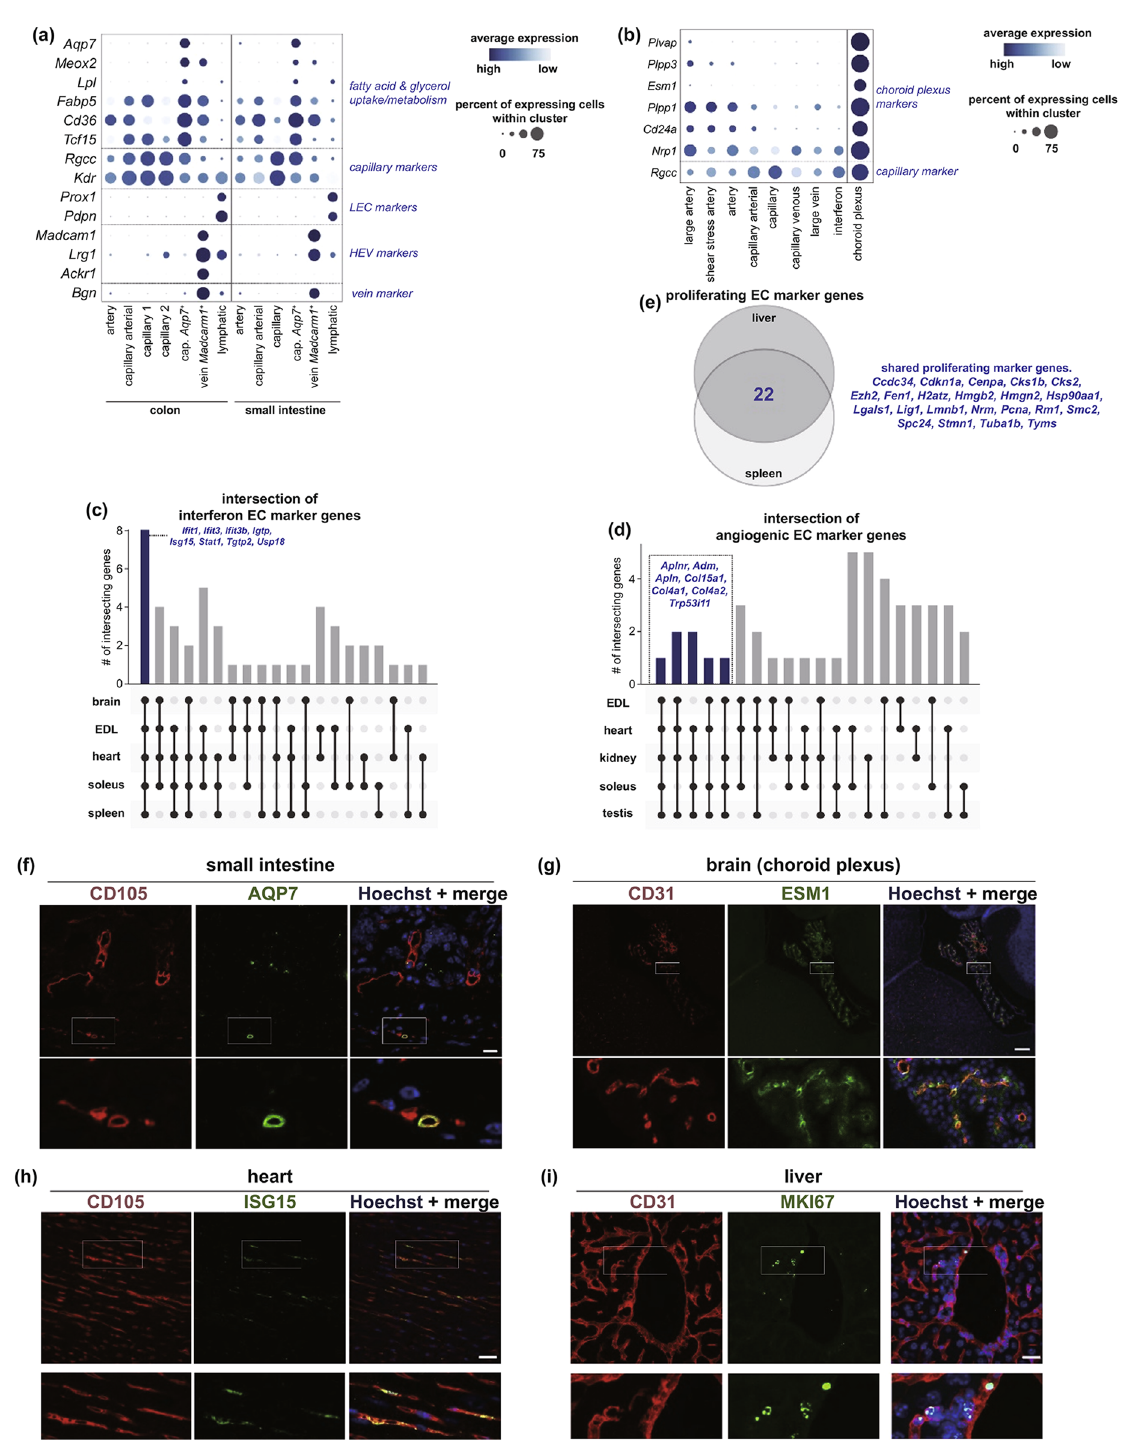
Fig. 7 Specialized and unexpected endothelial cells phenotypes. a , b Dot-plot heatmap of markers enriched in intestinal Aqp7 + capillary and Madcam1 + vein ECs. c , d UpSet plot of intersections between the top 50 markers expressed by interferon-activated. e Venn diagram show- ing genes upregulated in proliferating ECs. f – i Representative micrographs of mouse tissue sections. Reprinted from [95] with